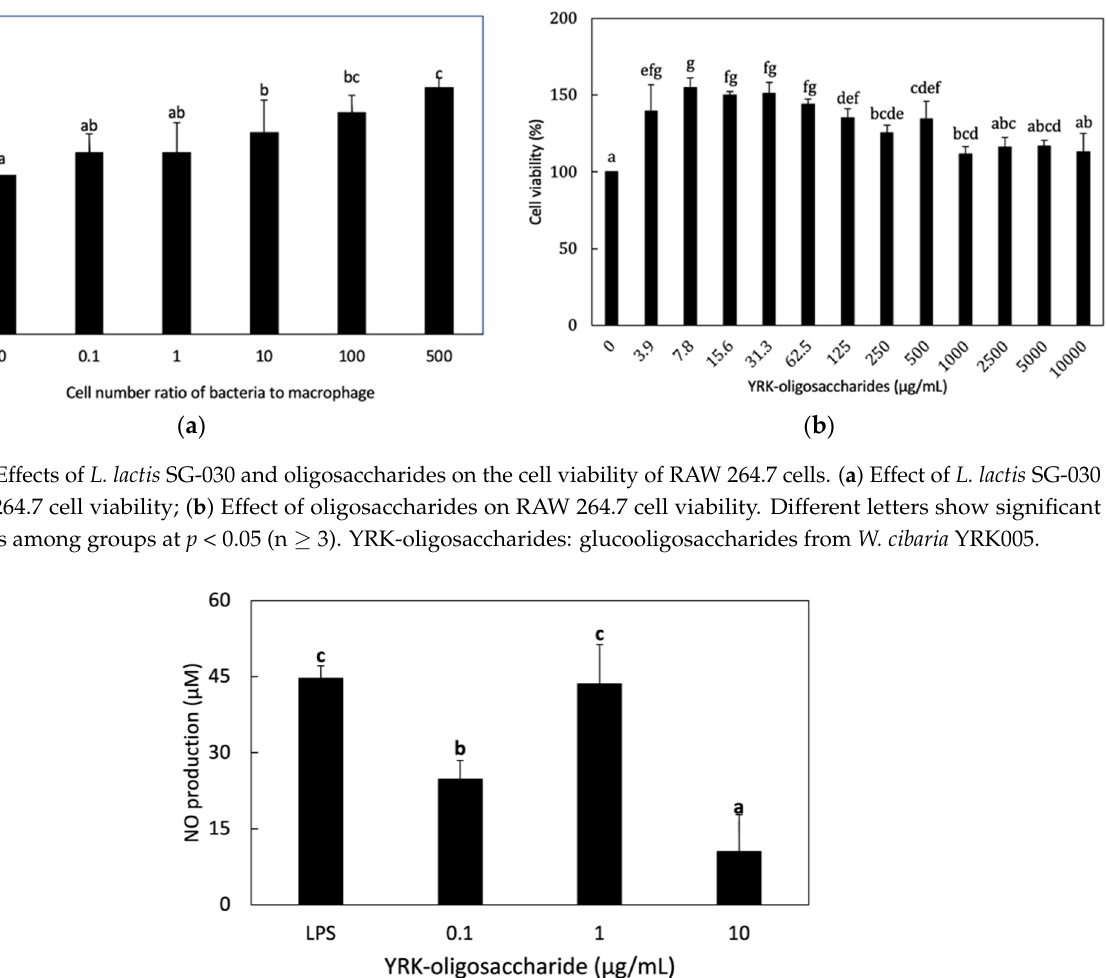
Figure 2. Effect of glucooligosaccharides on NO production in RAW 264.7 cells. RAW 264.7